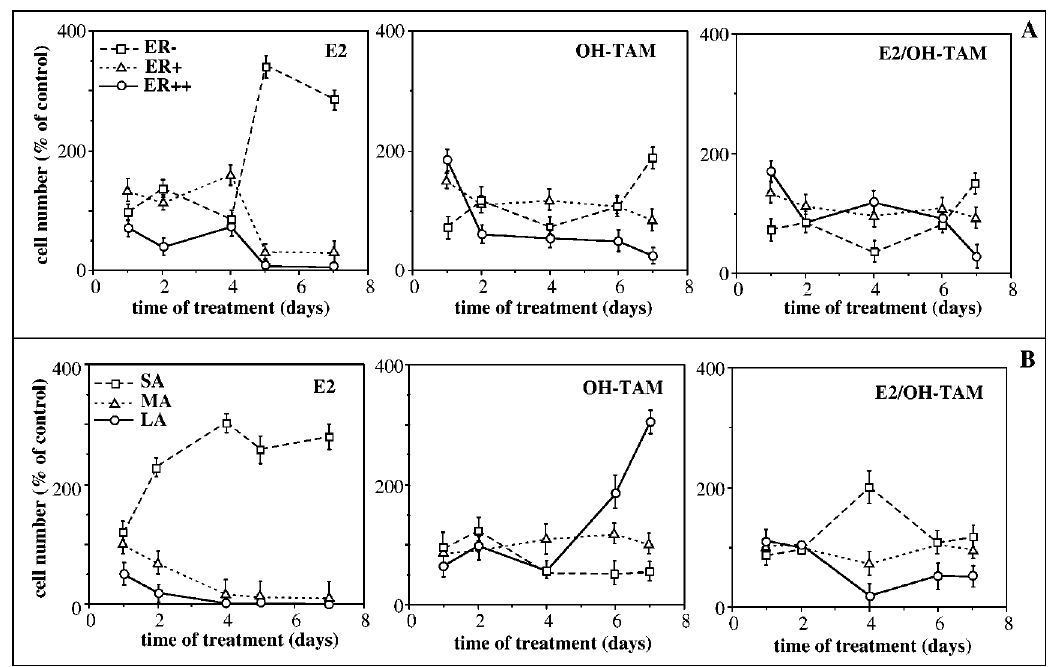
Fig. 5. A: Variations of the number of the three subpopulations ER − , ER + , ER ++ relative to control, versus the time of treatment. B: Variations of the number of the three subpopulations SA, MA, LA relative to the control, versus the time of treatment. Data are the mean (cid:6) SD from four independent experiments.